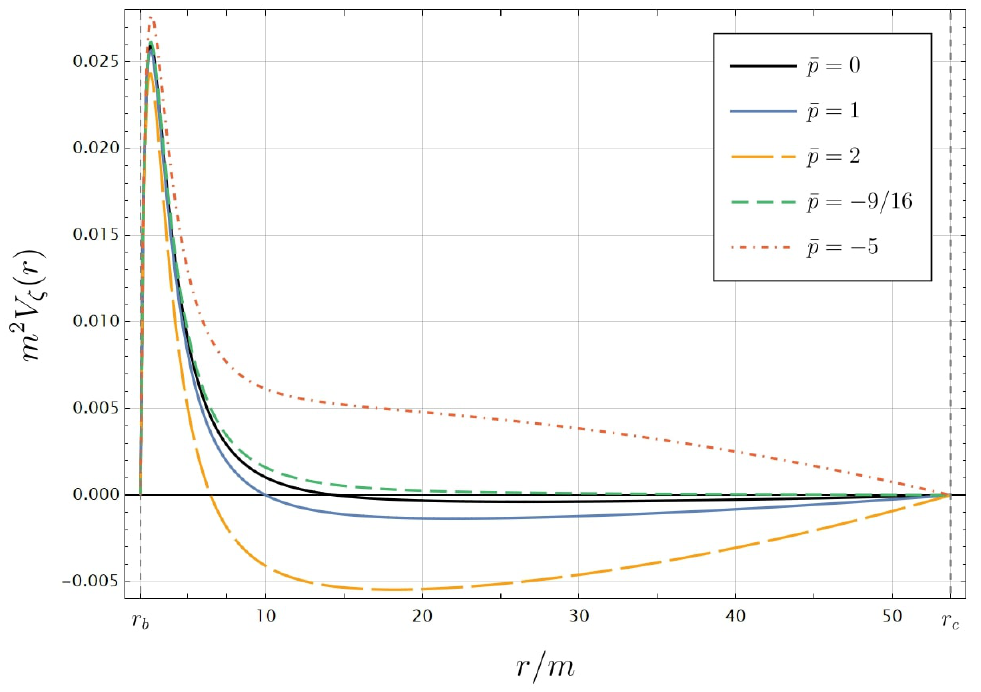
Figure 1 . Effective potential within the static region r b < r < r c for ‘ = 0 and different values of ¯ p . The cosmological constant is set to Λ = 0 . 001 /m 2 . The ¯ p = 0 curve represents the GR